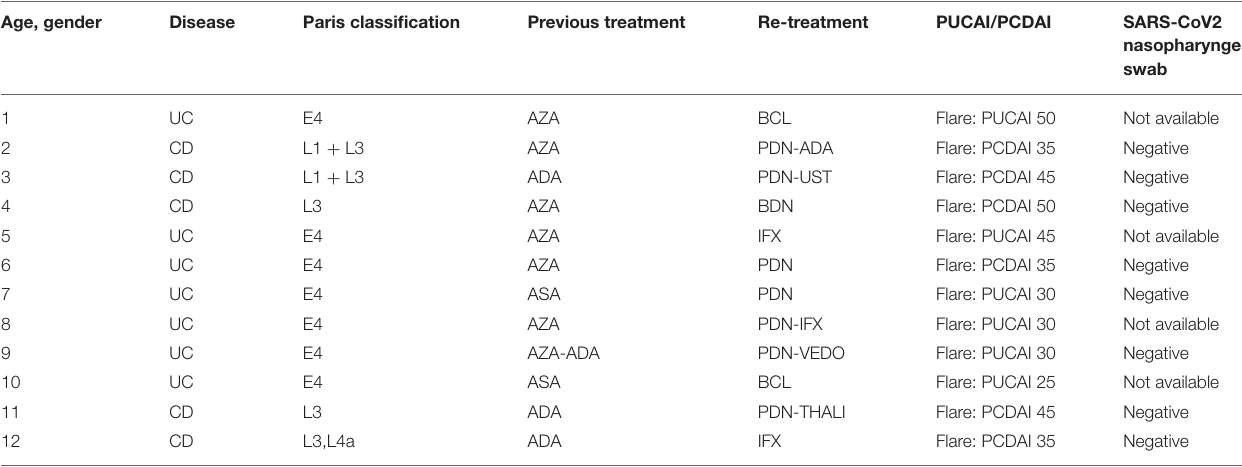
TABLE 3B | Clinical features of PIBD flares and SARS-CoV2 diagnostic testing. Age,